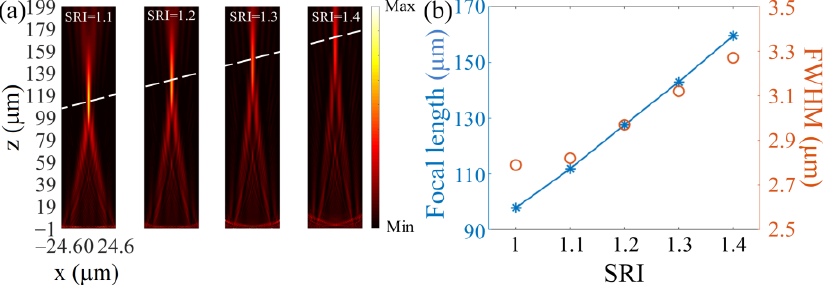
Figure 3. ( a ) Intensity profiles and ( b ) focal length and FWHM of the monolithic metalens as functions of the SRI.